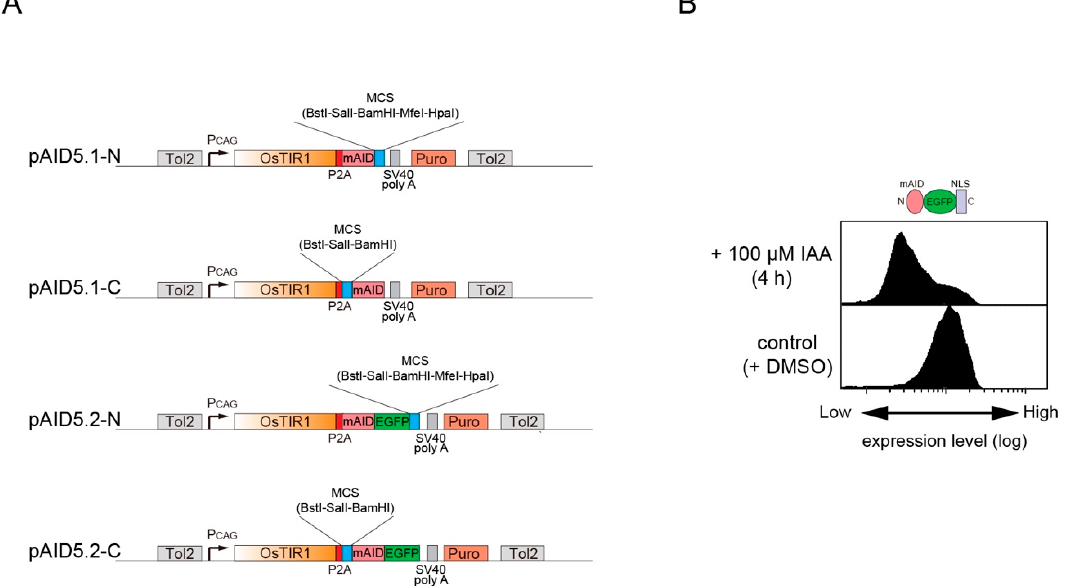
Figure 2. New all-in-one plasmids for controlling an mAID-fused protein. ( A ) Schematic illustration of pAID5.1-N/C and pAID5.2-N/C. A multi-cloning site (MCS) for cDNA cloning is shown in blue. ( B ) Reporter depletion in a clone derived from HCT116 cells. This clone was generated by introducing a plasmid based on pAID5.4-N. An mAID–EGFP–NLS reporter was detected after incubating the cells with or without 500 μ M IAA for 4 h.